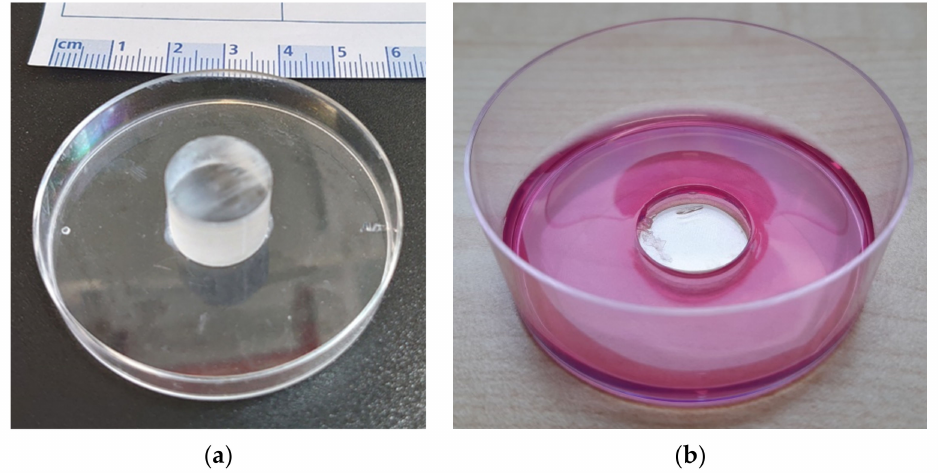
Figure 1. Plexiglas stamp for mold preparation ( a ) and the agarose mold ( b ). Bone cylinder will be placed into the hole in the